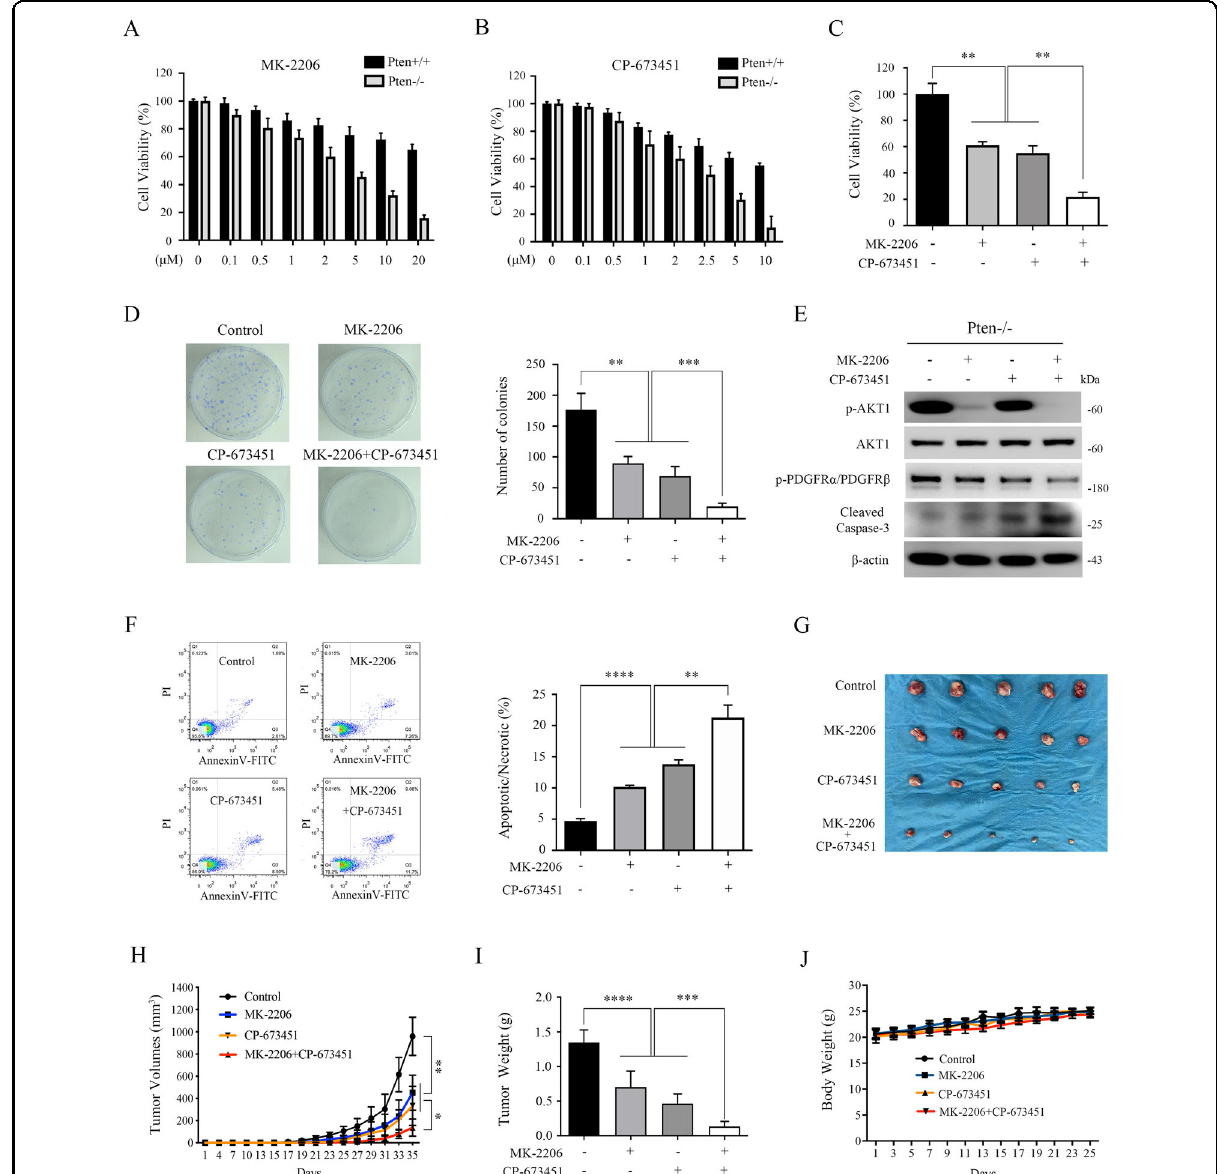
Fig. 8 The combination of MK-2206 and CP-673451 exerts a stronger inhibitory effect on the growth of Pten-de fi cient cells in vitro and in vivo than either agent alone. A, B Pten + / + and Pten − / − MEFs were treated with MK-2206 ( A ) or CP-673451 ( B ) as indicated concentrations for 48 h. Cell viability was measured with an MTT assay. C – F Pten − / − MEFs were treated with a combination of 2 μ M MK-2206 and 2 μ M CP-673451 or either agent alone for 48 h. Cell viability was tested by an MTT assay ( C ). The colonies formed by the indicated cells were stained and counted, representative images (left panel) and quanti fi cation (right panel) ( D ). Cell lysates were subjected to immunoblotting with the indicated antibodies ( E ). Apoptosis assay was used to detect apoptosis changes in control cells and drug-treated Pten − / − MEFs ( F ). G – J U373 cells were inoculated subcutaneously into the nude mice to evaluate the effects of MK-2206 or CP-673451, respectively, or in combination in vivo. Dissected tumors ( G ). Tumor volume growth curves ( H ). Tumor weight ( I ). Body weights of mice ( J ). Error bars indicate mean ± SD of triplicate samples. * P < 0.05; ** P < 0.01; *** P < 0.001; **** P <